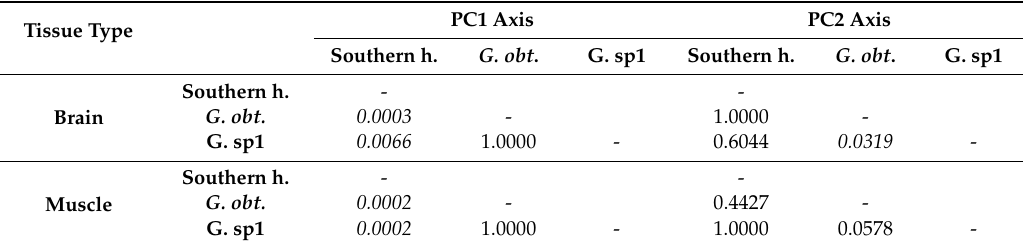
Table 4. Group di ff erentiations of the three cryptic species based on pairwise KW tests. Significant group di ff erences / p < 0.05 / are